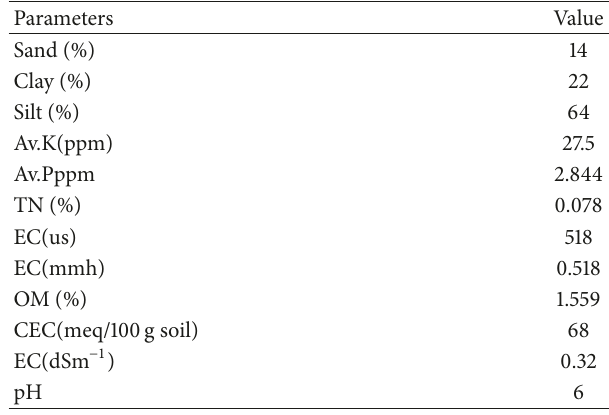
Table 1: Chemical and physical characteristics of the soil of experimental